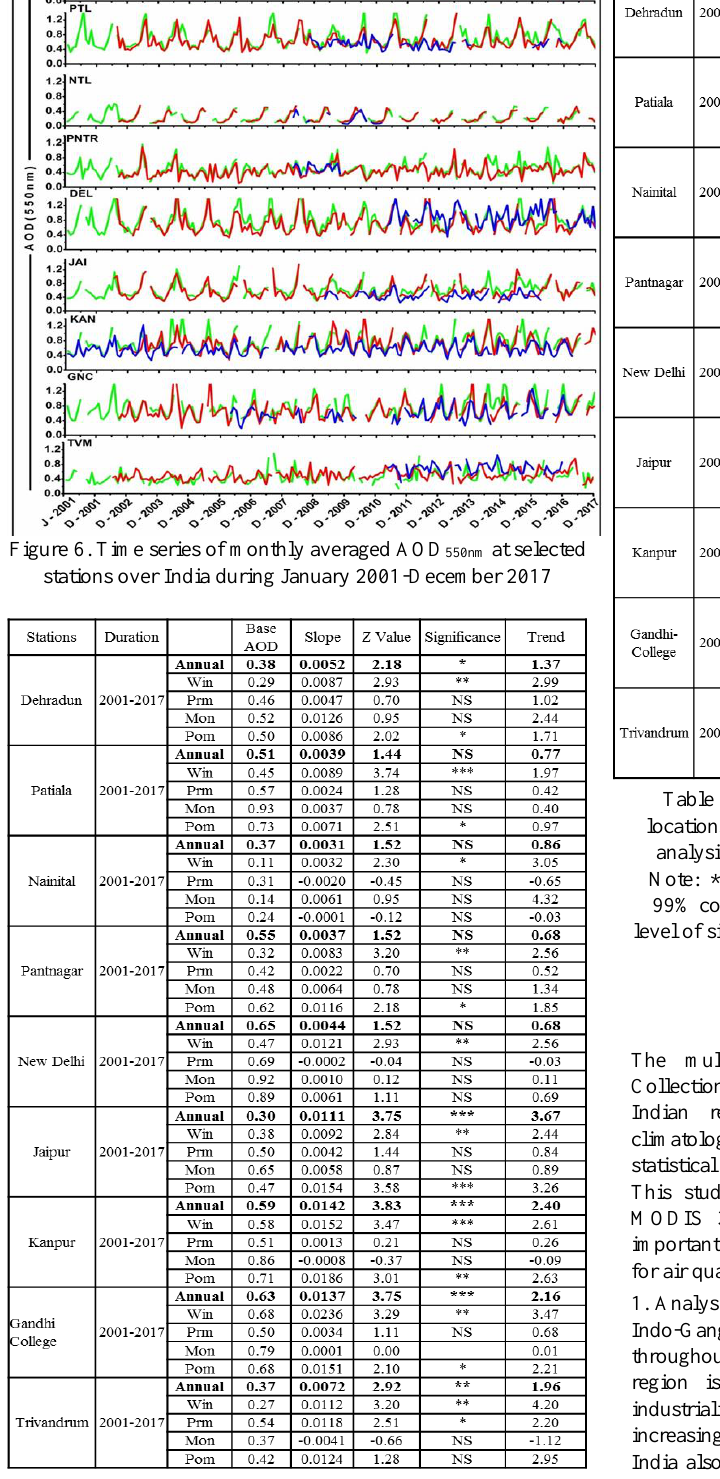
Table 2. Statistics of MODIS Terra AOD 550nm at different locations over India for the time period of 2001–2017.Trend analysis was done with non-parametric Mann-Kendall test. Note: *** for 99.9% confidence level of significance, ** for 99% confidence level of significance, * for 95% confidence level of significance, + for 90% confidence level of significance and NS for no significance.